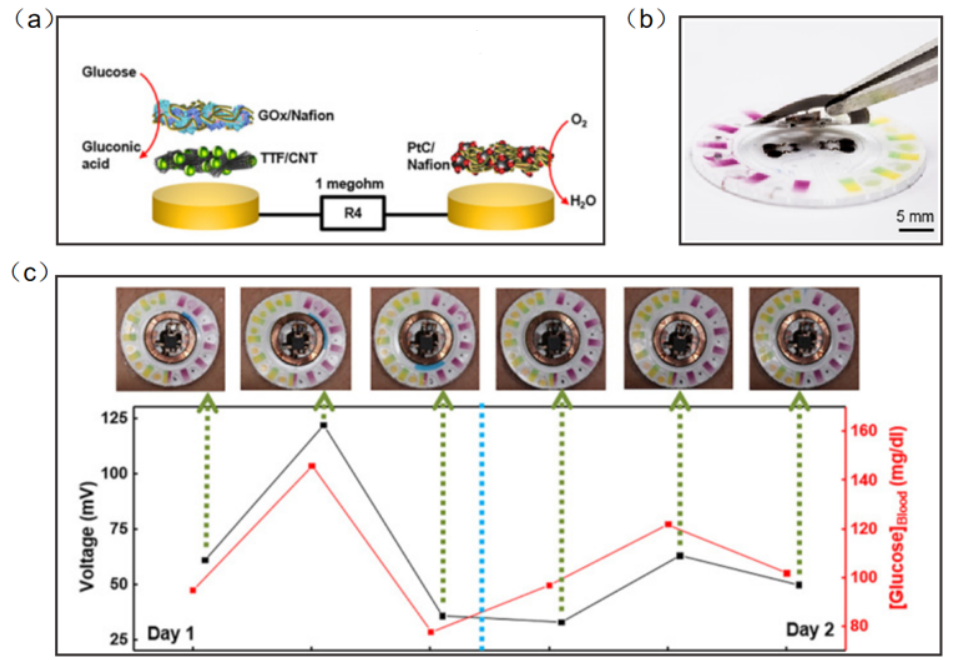
Figure 11. ( a ) Exploded-view schematic illustration of the layer makeup of the biofuel cell-based glucose sensor [115]. ( b ) The exploded view of the complete hybrid battery-free system [115]. ( c ) Correlation of data acquired from glucose sensors with those acquired from blood glucose over a period of 2 days for subject [115]. Reprinted with permission from Ref. [115]. Copyright© 2022, The American Association for the Advancement of